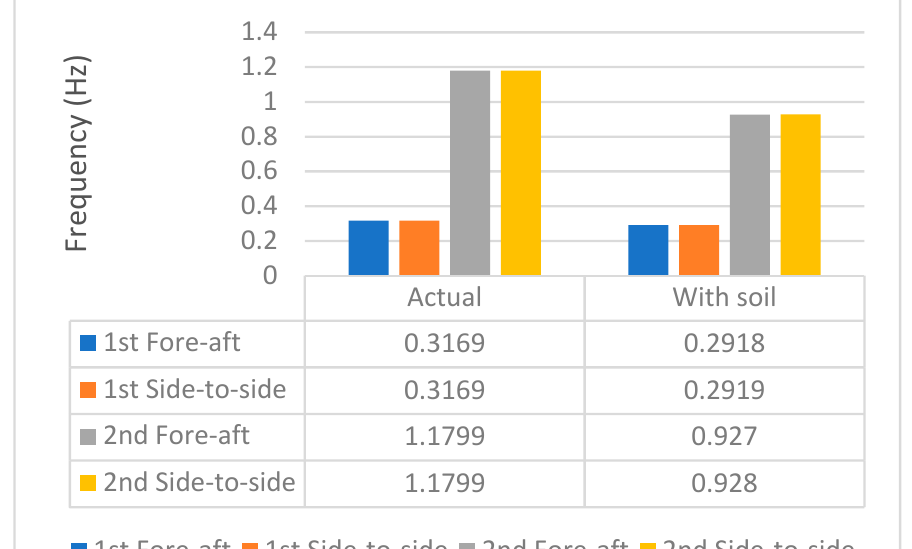
Figure 13. Dynamic response with and without soil.